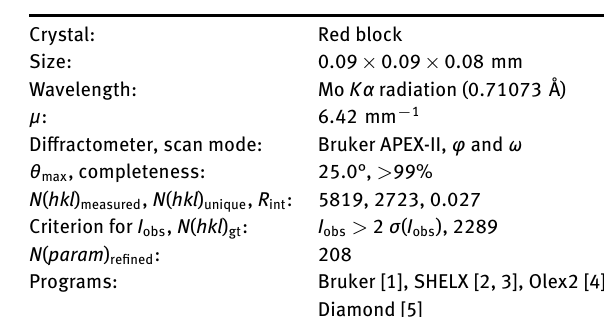
Table 1: Data collection and